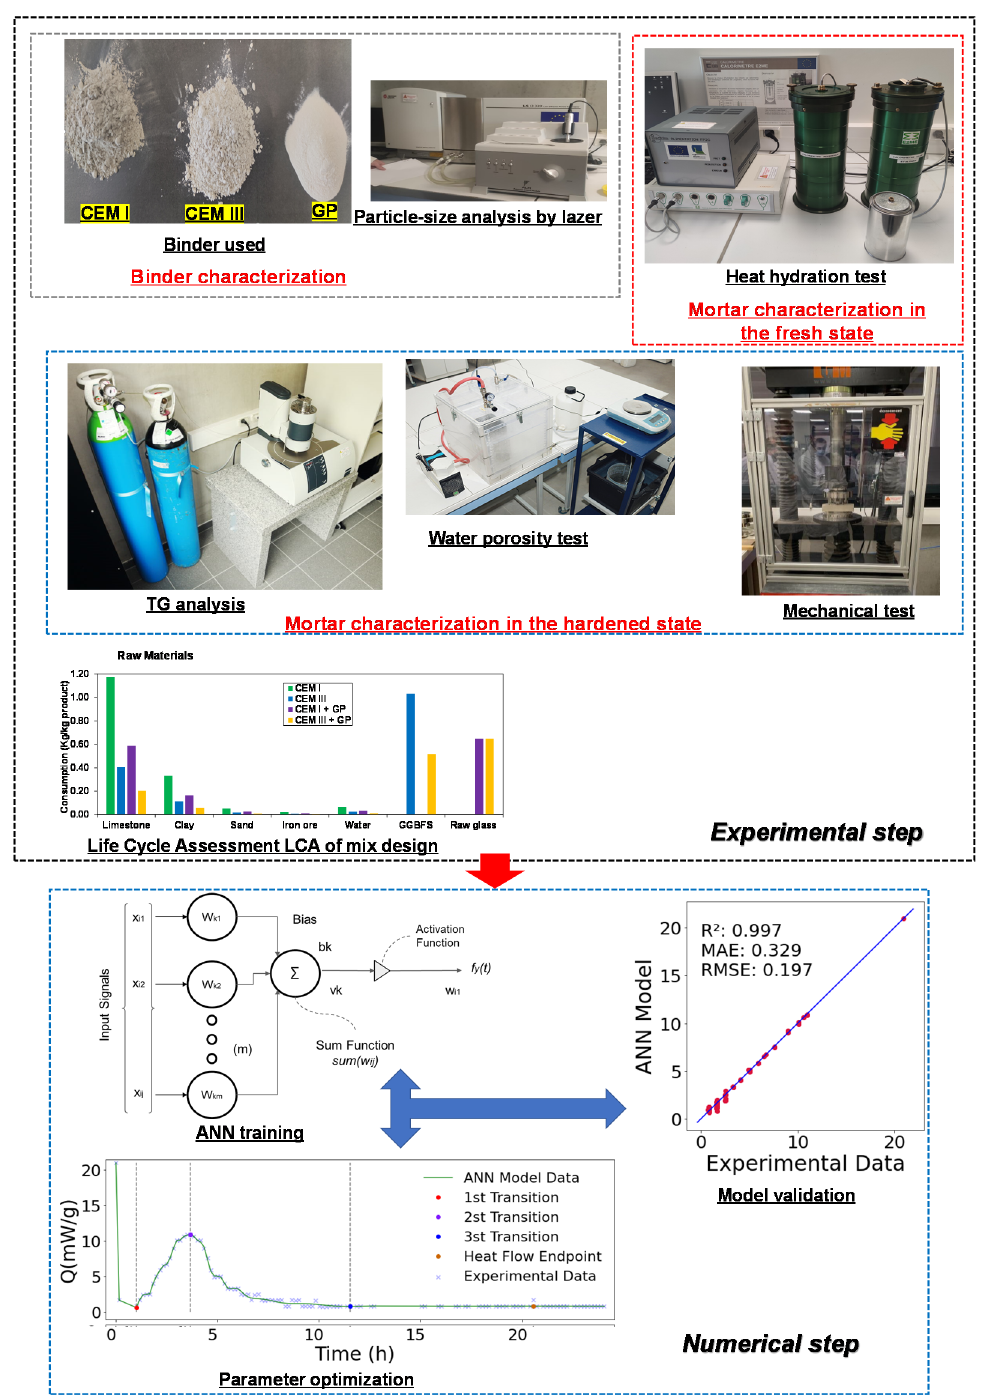
Figure 2. Conceptual study plan.